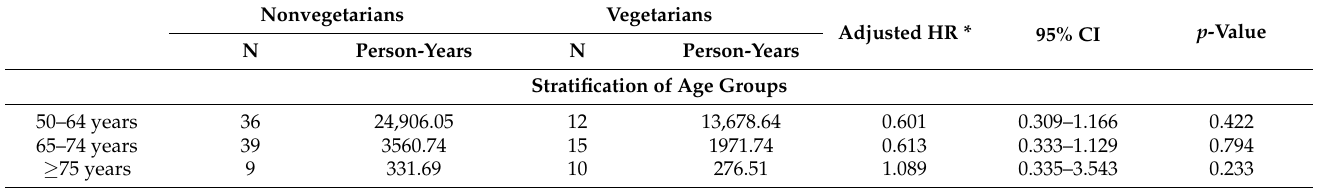
Table 4. Risk of developing dementia in vegetarians compared with nonvegetarians in age